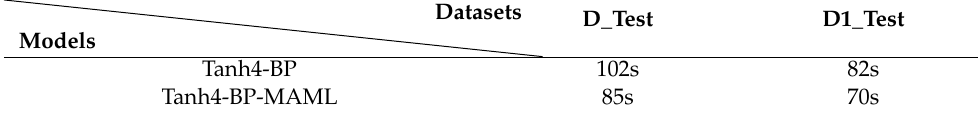
Table 5. Comparison of training time of different models with different datasets.